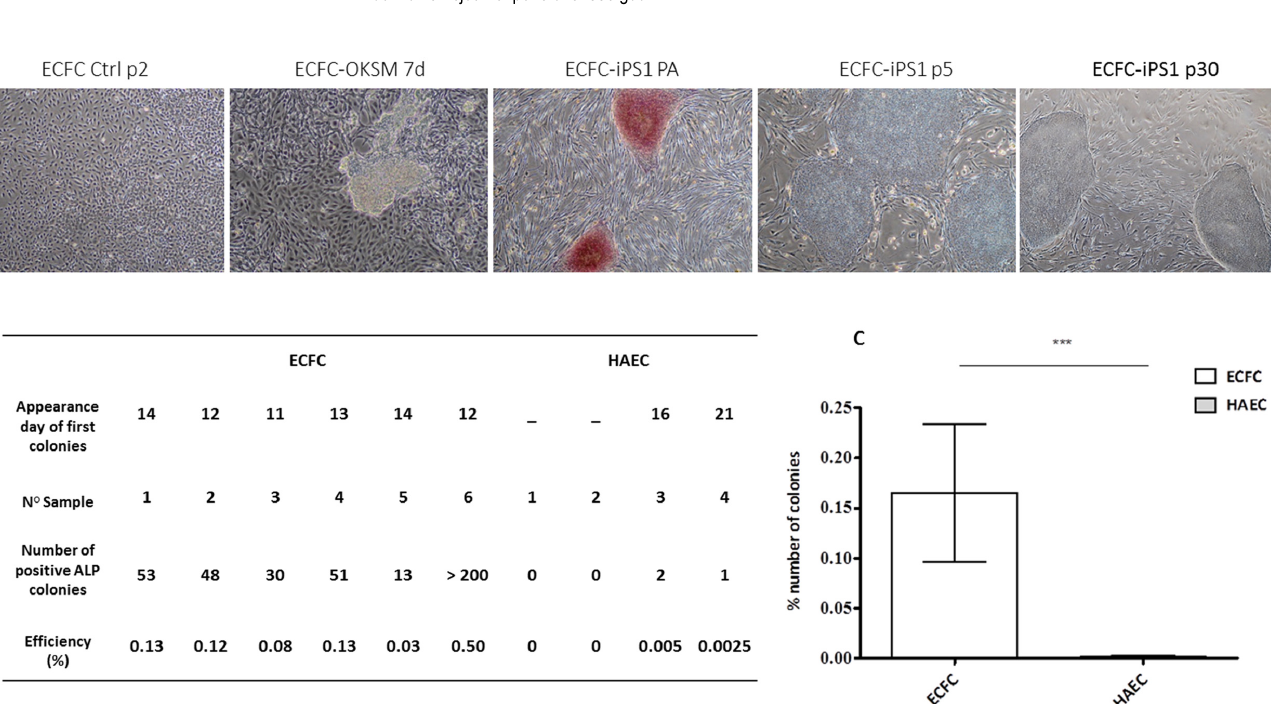
PLOS ONE | DOI:10.1371/journal.pone.0152993 April 4,